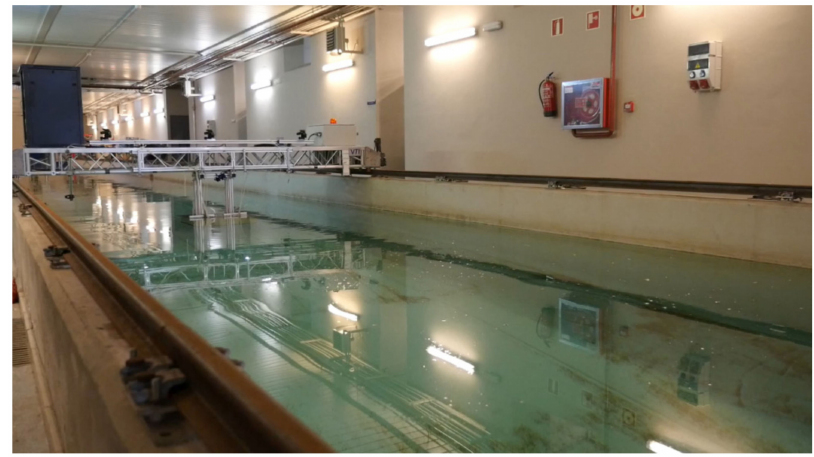
Figure 6. Experimental tests at the towing tank of Universidade da Coruña.